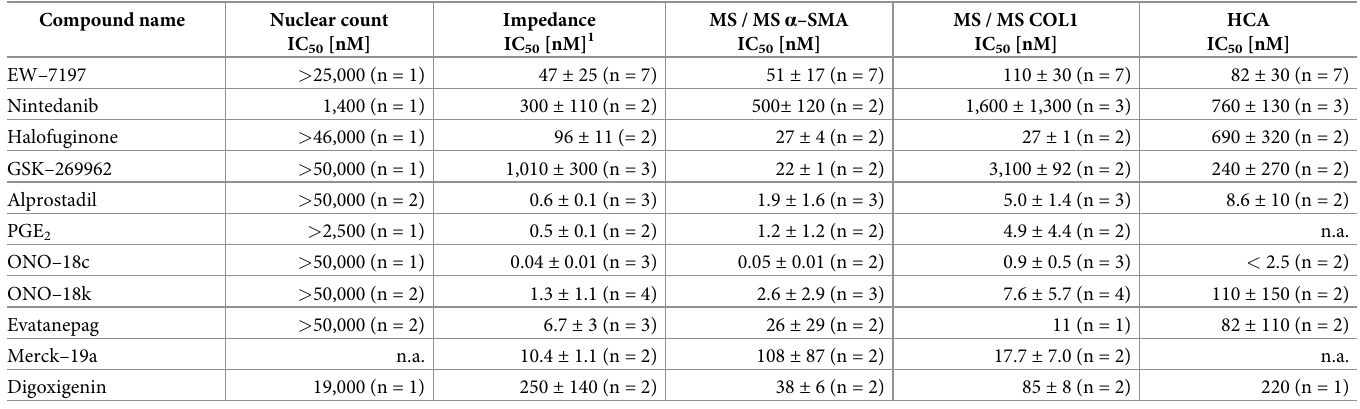
Table 3. IC 50 values of selected compounds in the standard